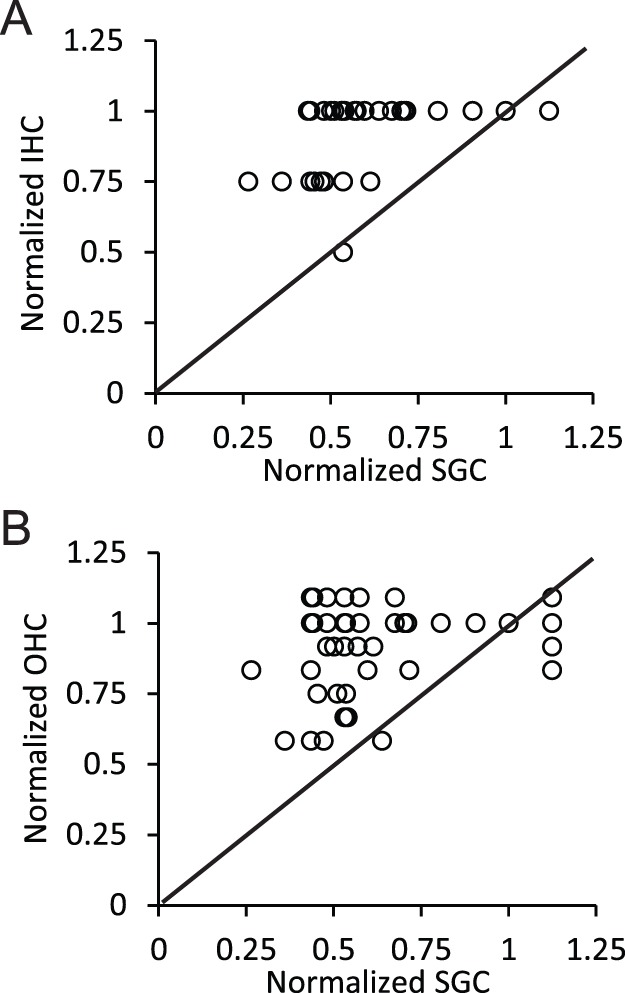
Relationship between the hair cells and spiral ganglion cells.Age-normalized inner (A) and outer (B) hair cell counts as a function of age-normalized packing density of SGCs. The solid diagonal line represents the unity line. Points that fall above the unity indicate a greater loss of spiral ganglion cells compared to the hair cells.